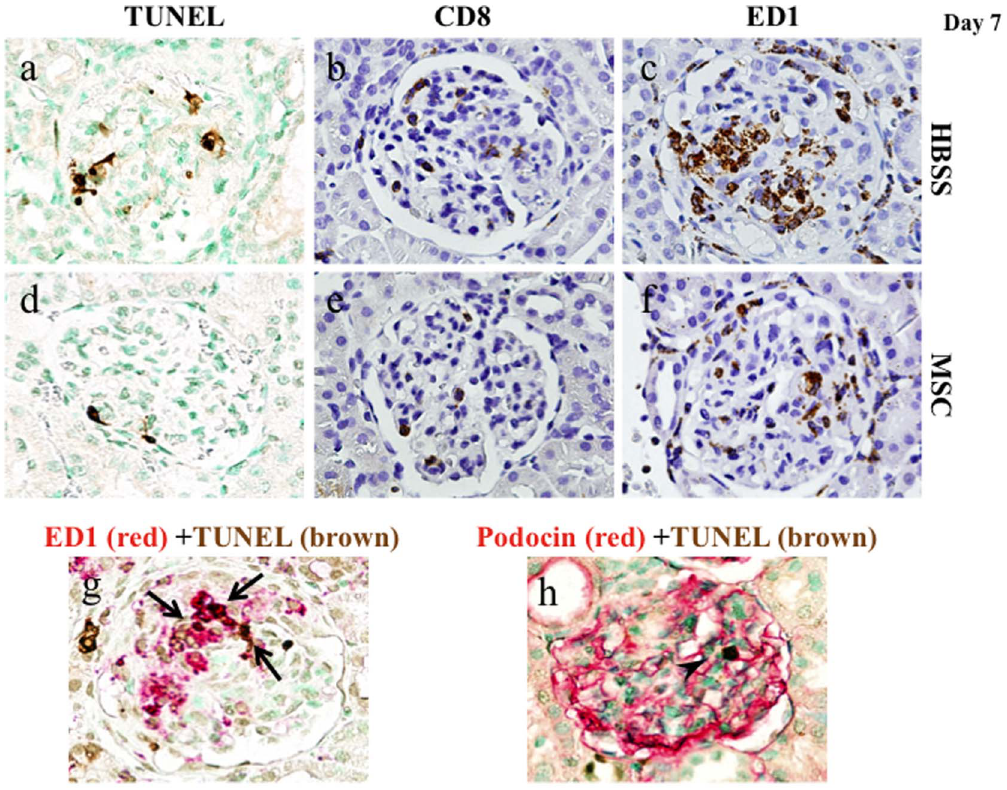
Figure 3. Immunohistochemistry for TUNEL, CD8, and ED-1 in the study groups. Representative pictures stained with immunohistochemistry for TUNEL (a, d), CD8 (b, e), and ED-1 (c, f) of an HBSS-treated rat (a–c) and an MSC-treated rat (d–f) on day 7. Kidney sections were stained using two-color immunohistochemistry with ED1 or podocin stained red and TUNEL stained brown in an HBSS-treated rat (g,h). Some portion of the TUNEL + cells is stained with ED1 + (arrows) and podocin + (arrowhead), Original magnifications,